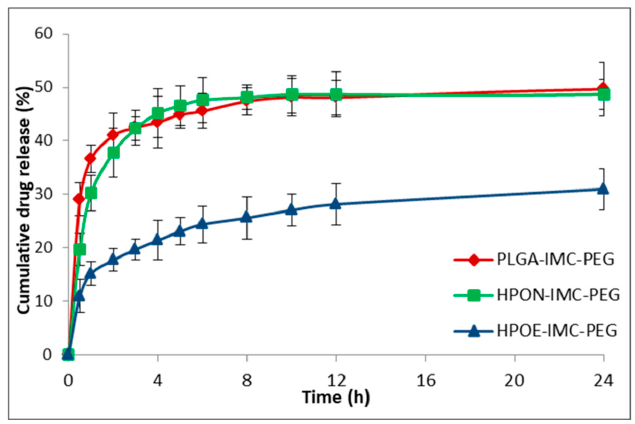
Figure 7. In vitro release profile of IMC from PEG-coated nanocarriers.